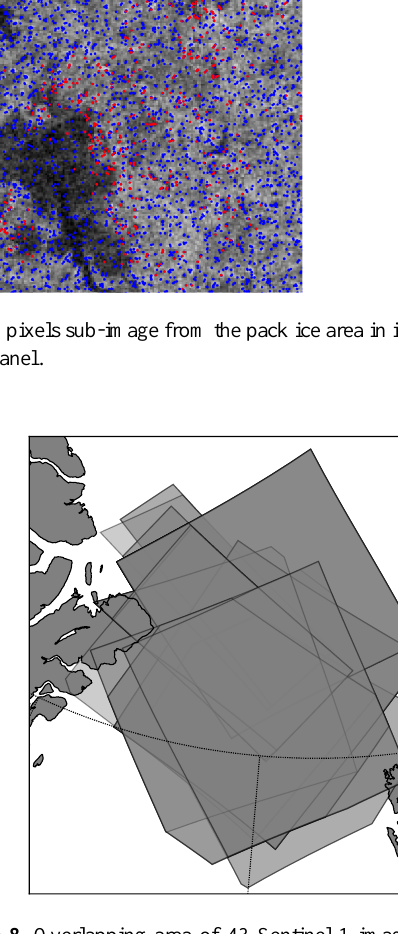
Figure 8. Overlapping area of 43 Sentinel-1 image pairs used to compare ORB, SIFT and SURF. The image pairs have been ac- quired between 2 January and 21 March 2015 with time gaps vary- ing between 7 and